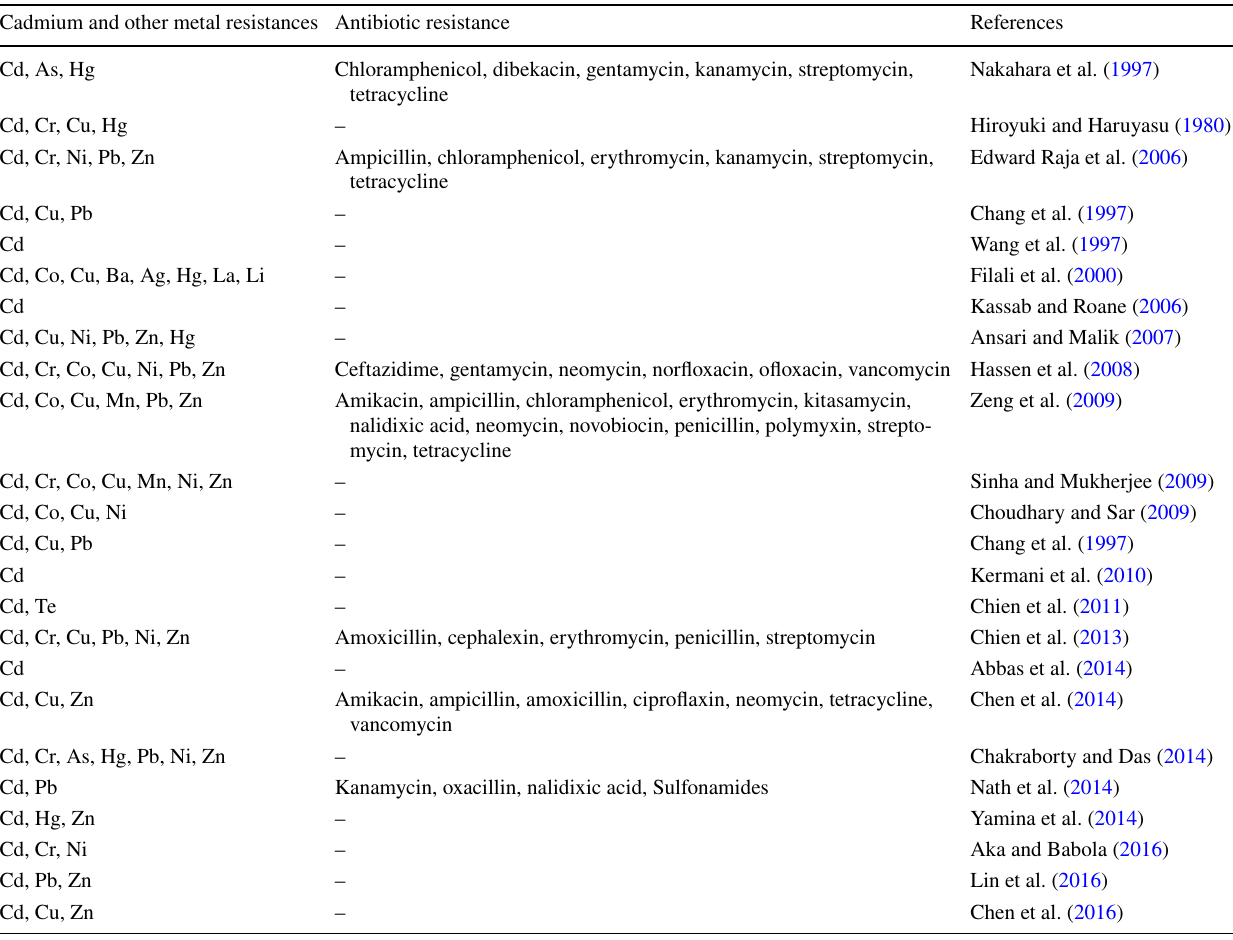
Table 2 Co selection of heavy metals and antibiotic resistances of P . aeruginosa Cadmium and other metal resistances Antibiotic